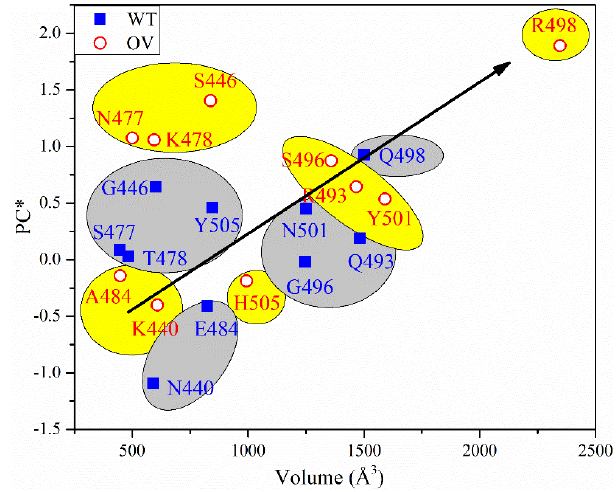
Figure 6. PC* vs. volume for 10 sites before and after mutation.